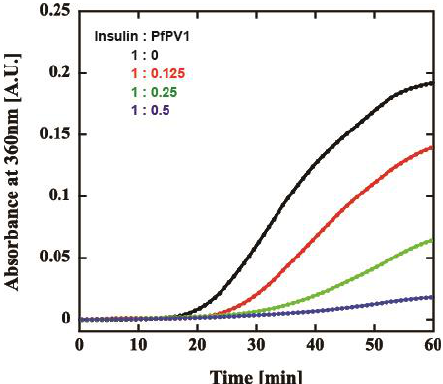
Figure 5. Effect of rPfPV1-Strep on the aggregation of insulin. Dithiothreitol (DTT)-induced insulin aggregation in the presence of rPfPV1-Strep at weight ratios of 1:0 (black), 1:0.1 (red), 1:0.25 (green), and 1:0.5 (blue) was monitored at an absorbance of 360 nm.